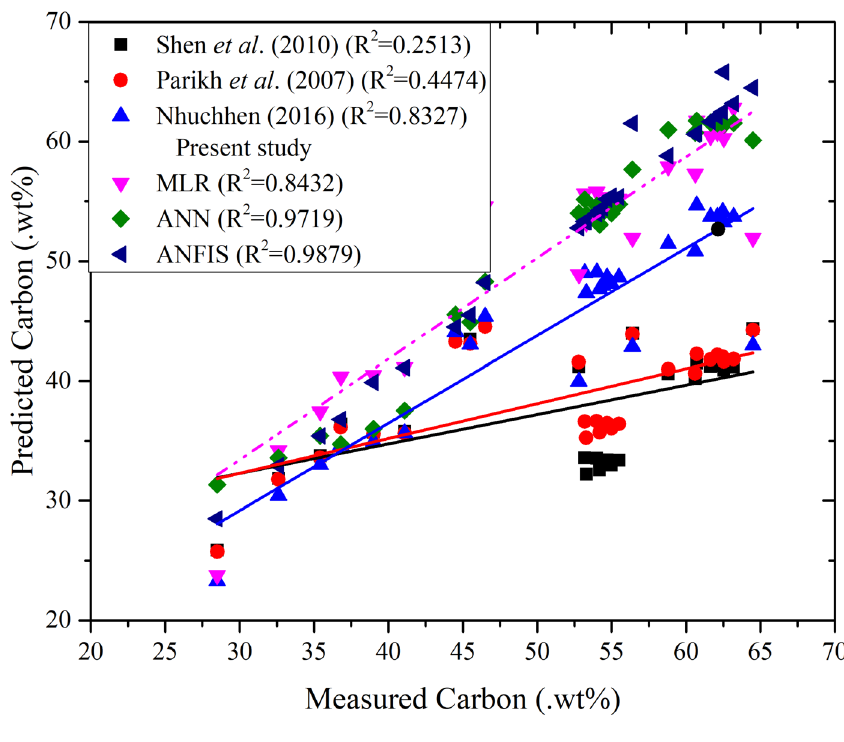
Fig. 8 Comparison of the predicted C with the measured carbon